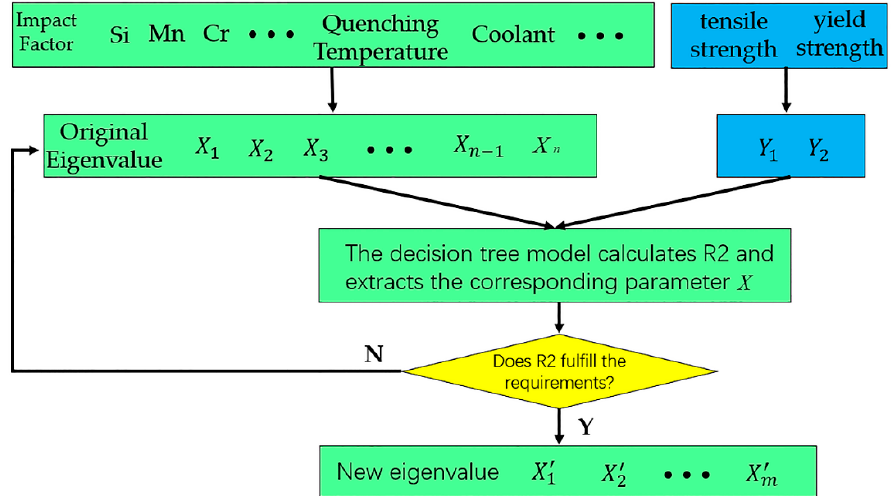
Figure 2. Flow chart of the forward selection (FS) method.